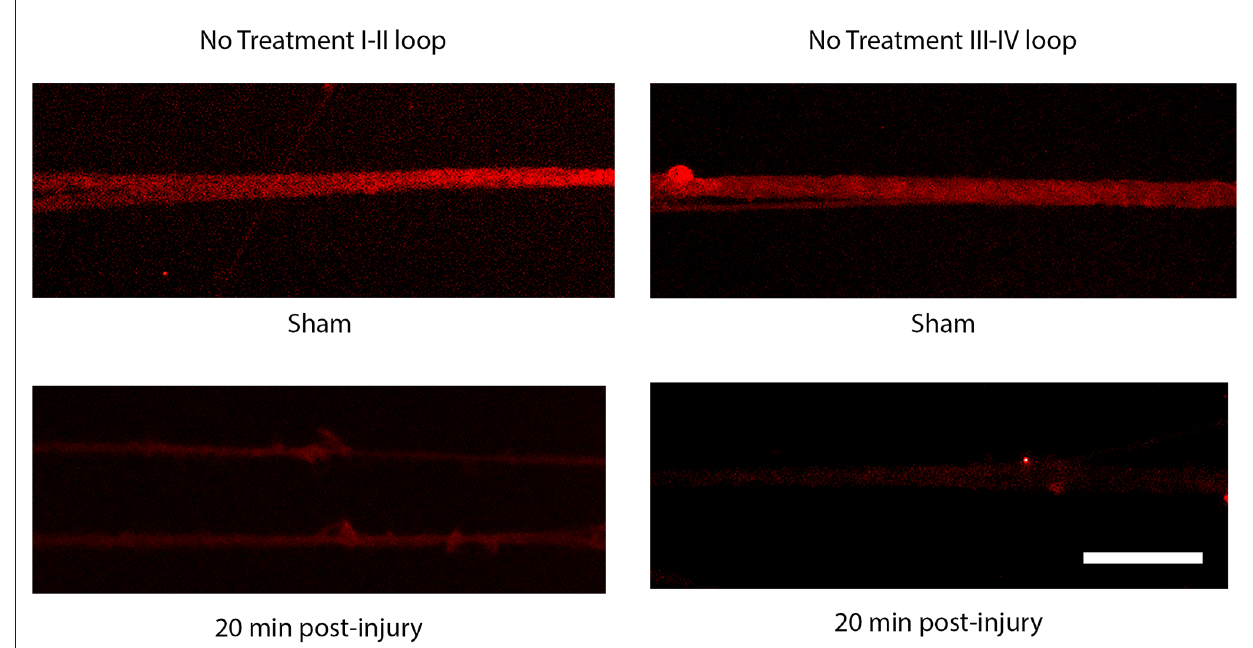
FIGURE5 Immunoreactivity of the I-II loop and III-IV loops of the sodium channel. The III-IV loop is cleaved by calcium activated proteases and is lost at 20 post injury. The I-II loop is retained within the cell membrane and is present at 20 post injury. Scale bar = 10 µ